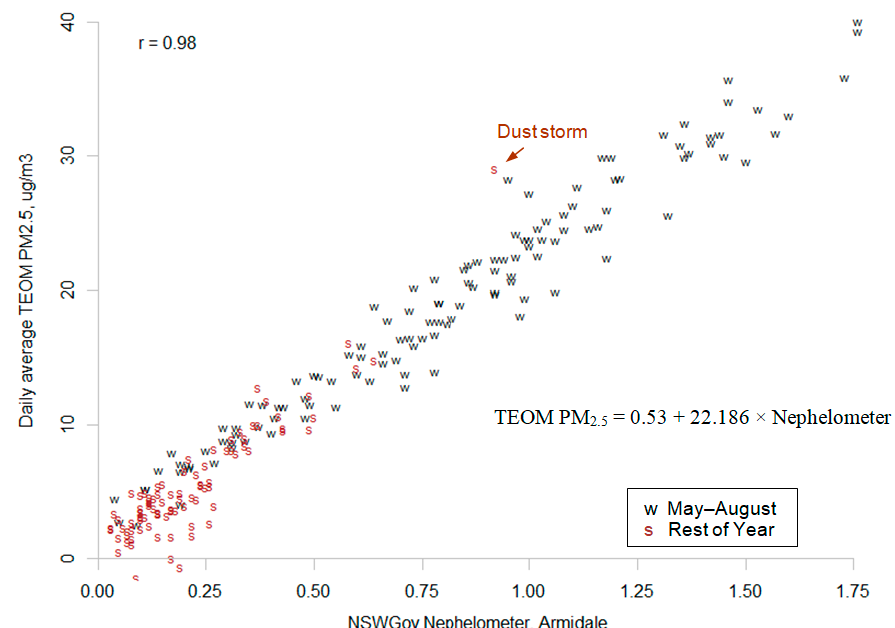
Figure 2. Comparison of daily average PM 2.5 and nephelometer measurements at the NSW government station, Armidale.